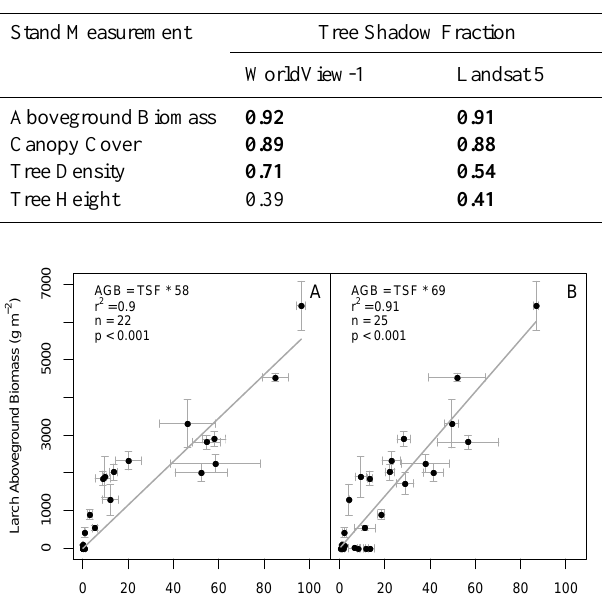
MODIS VCF ( r = 0 . 76, p < 0 . 001, n = 5000) and MODIS TCC ( r = 0 . 81, p < 0 . 001, n = 5000). Forest patches